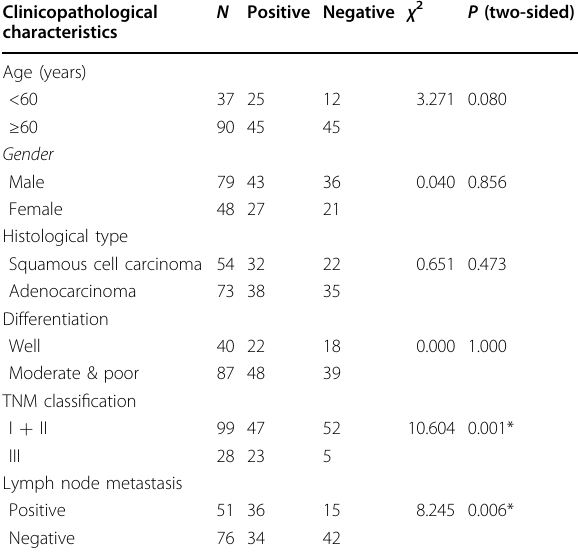
Table 2 Summary of Cox univariate and multivariate regression analysis of the association between clinicopathological characteristics and overall survival in 93 cases of non-small cell lung